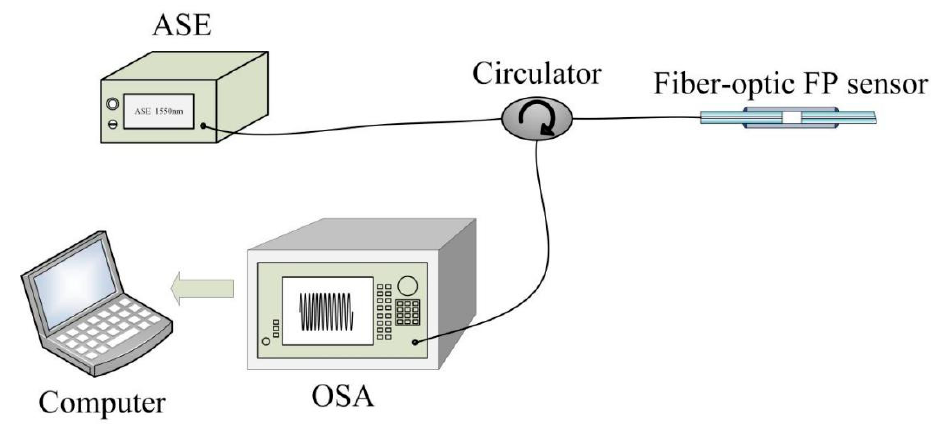
Figure 9. Schematic of the experimental system for cavity-length interrogation.